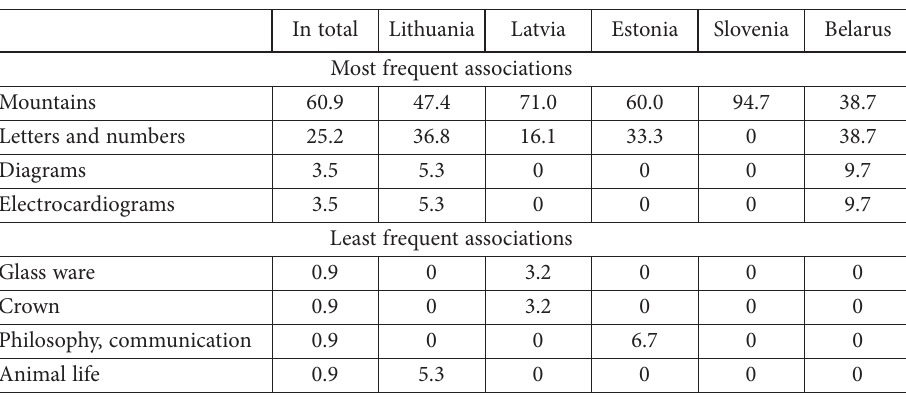
Table 8. Interpretations of Fragment 4 (%) (source: created by authors) In